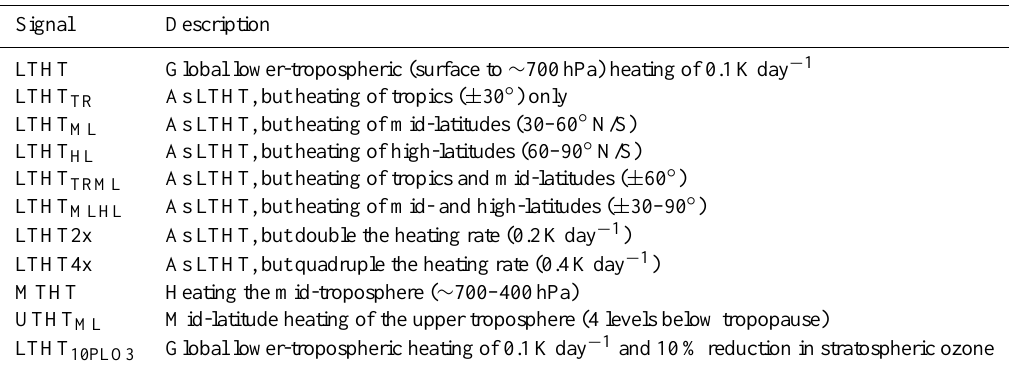
Table 2. Tropospheric heating experiments. Signal Description